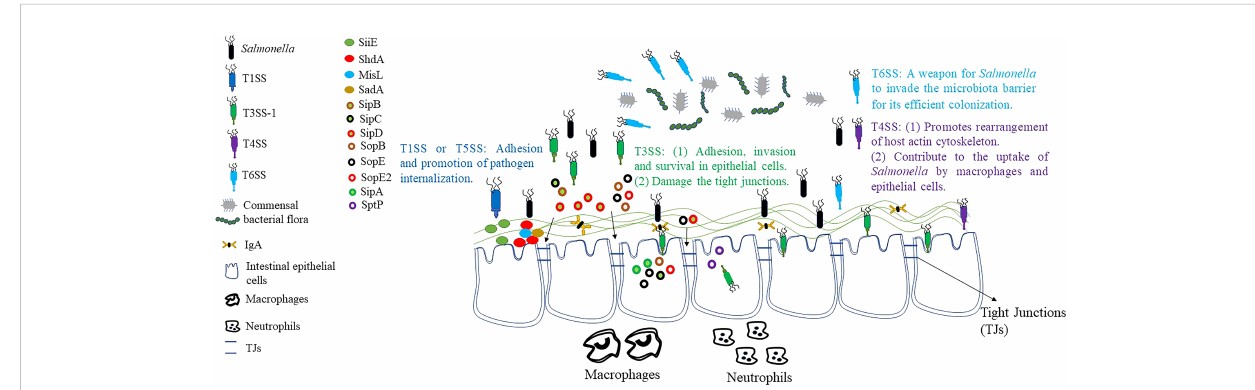
FIGURE 1 Breakthrough of the intestinal barrier by Salmonella . Before it reaches the intestine, Salmonella utilizes the T6SS to compete with intestinal commensal microorganisms. T1SS and T5SS facilitate the attachment and internalization of Salmonella to IECs. T4SS also contributes to host cytoskeletal rearrangement, which in turn promotes the uptake of Salmonella by macrophages and IECs. Through T3SS-1, Salmonella secretes effector proteins that lead to membrane ruf fl es, macropinocytosis and bacterial internalization, and ultimately invasion of host cells. At the same time, the effector protein secreted by T3SS-1 helps Salmonella to destroy TJs, which in turn breach the intestinal barrier. However, Salmonella also secretes effector proteins, such as SptP, that restore membrane structure after bacterial internalization and reverse the effects of membrane ruf fl es caused by other effector